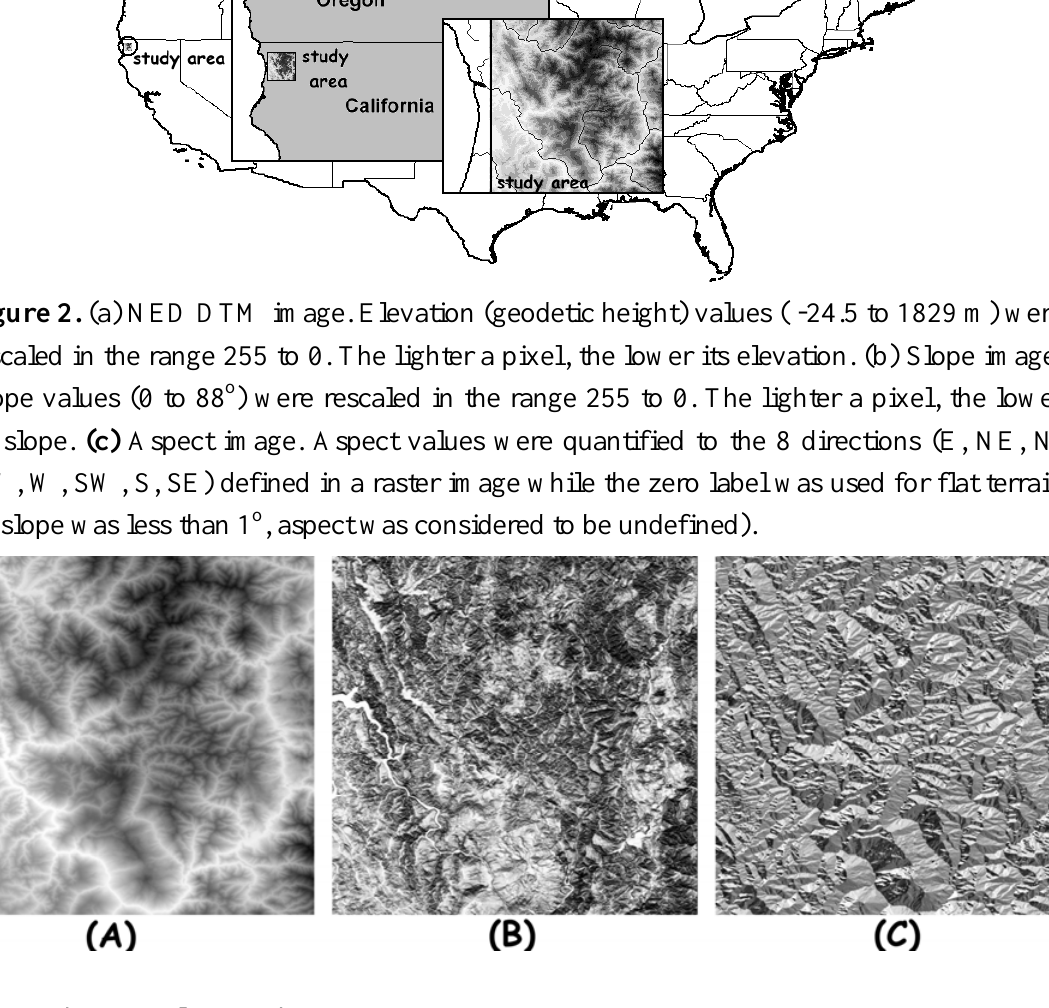
Figure 1. Location of the study area within the USA.